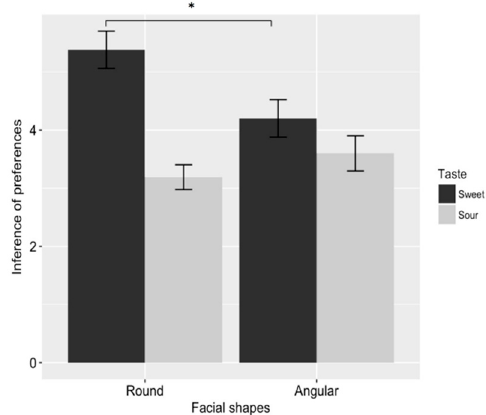
Figure 3. Results of Study 2. The round-faced (vs. angular-faced) person was perceived as more strongly preferring sweet (vs. sour) foods, while the angular-faced person was not to be perceived as liking sour (vs. sweet) foods. Error bars represent standard error. Asterisks denote significant difference ( p < 0.05 *).